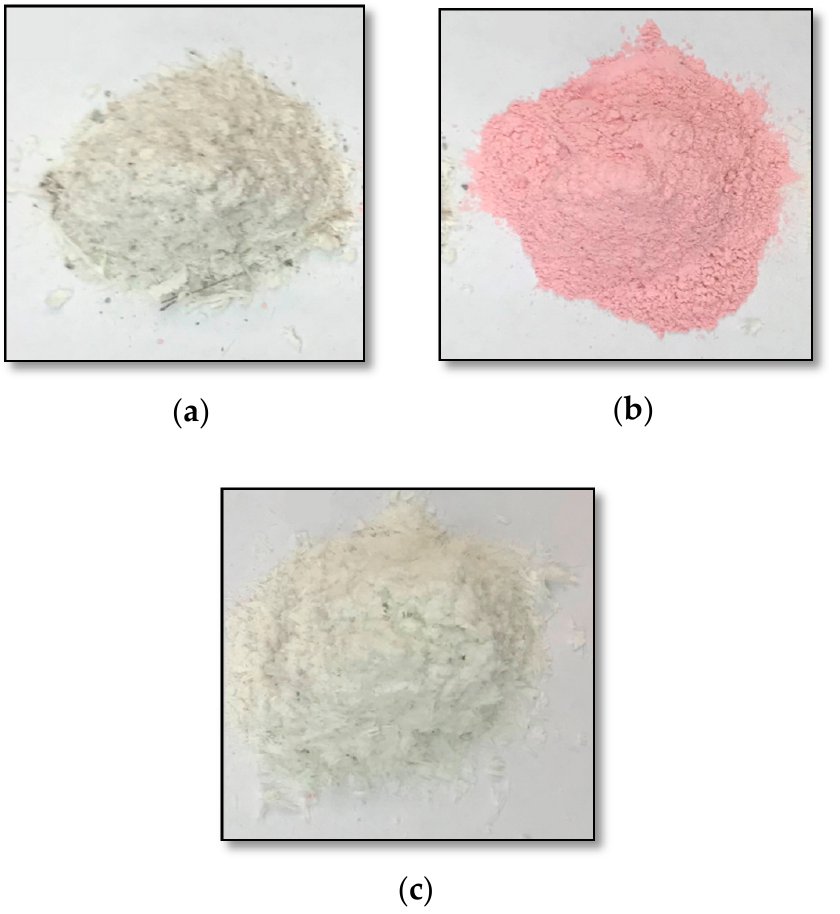
Figure 1. Wind turbine waste fractions from: ( a ) the aerodynamic part of the rotor blade—fraction I; ( b ) monolithic part of the turbine blade, which is used to fasten the entire blade element—fraction II; ( c ) the aerodynamic part of the rotor blade—fraction III.